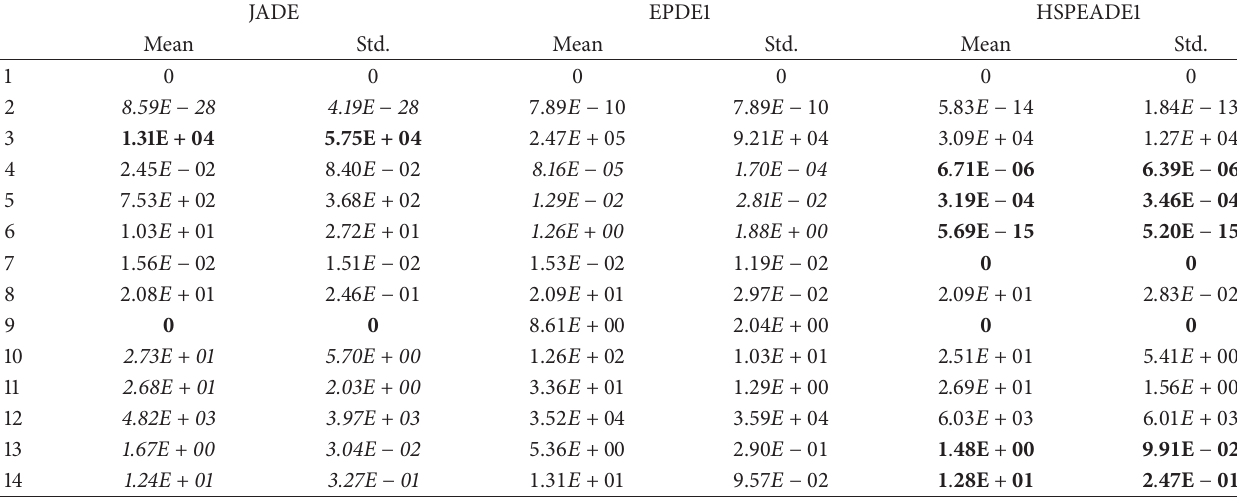
Table 1: Performance of JADE, EPDE1, and HSEPDE1 on 30D problems.